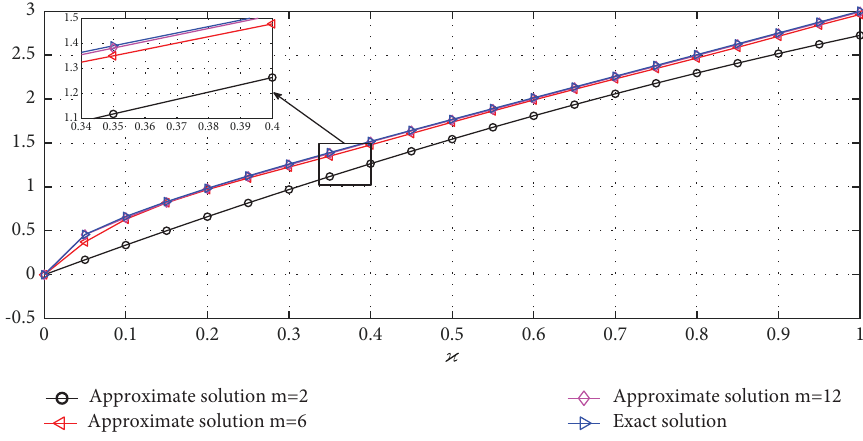
Figure 7: Exact and approximate solutions for diferent m for Example